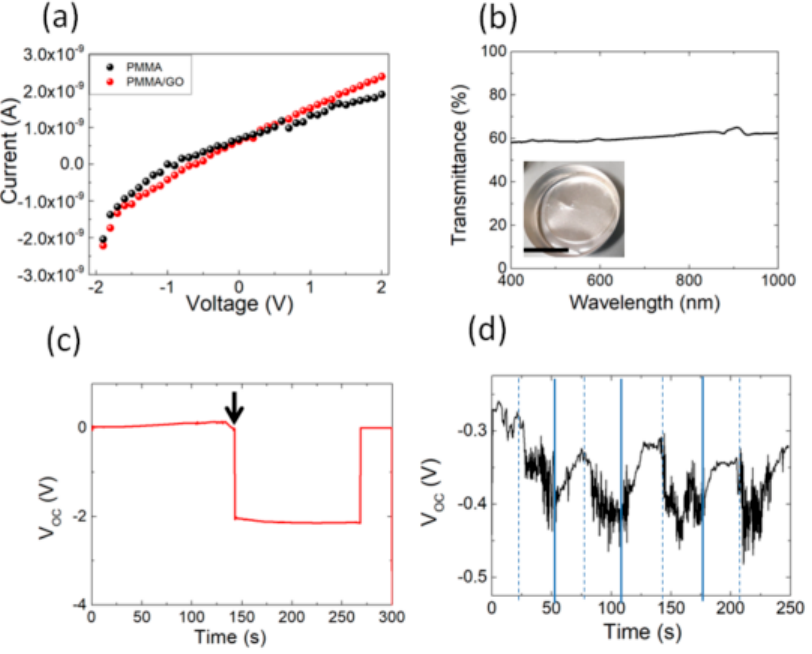
Figure 4. ( a ) Current-voltage characteristic plots of PMMA and PMMA/GO films. ( b ) UV–Vis transmittance spectrum of the PMMA/GO film. The inset shows the photograph of the PMMA/GO film into an aluminum mold (the scale bar indicates 2 cm). ( c ) Open-circuit voltage (V oc ) change during water droplet evaporation (the arrow indicates the instant of time in which the drops of water come into contact with the sample) from PMMA/GO films under ambient conditions. ( d ) V OC change under constant air speed ( ≈ 1 m/s) in the laboratory environment. The dashed lines indicate when the air flow was turned on. The continuous lines indicate when the aerosol was switched on.